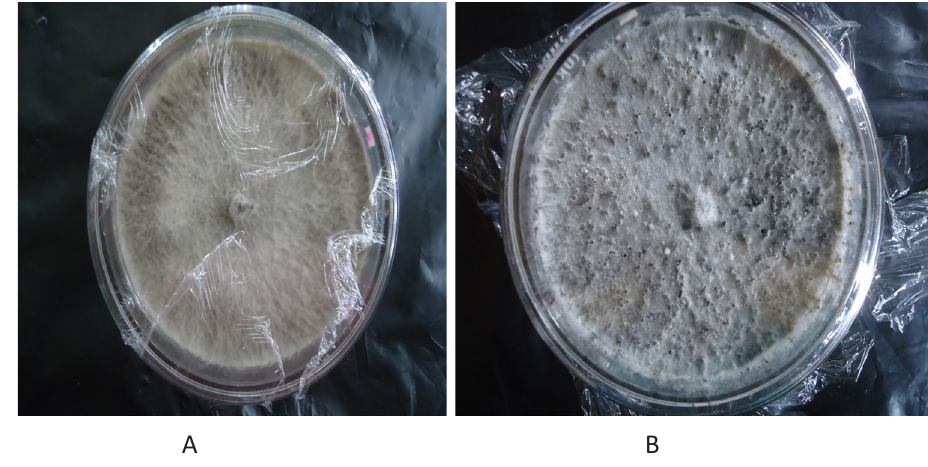
Figure 1: Colonies of A - Colletotrichum sp. and B - Lasiodiplodia sp., isolated respectively from an anthracnose lesion and SER in papaya (cv. Red Lady) fruit.